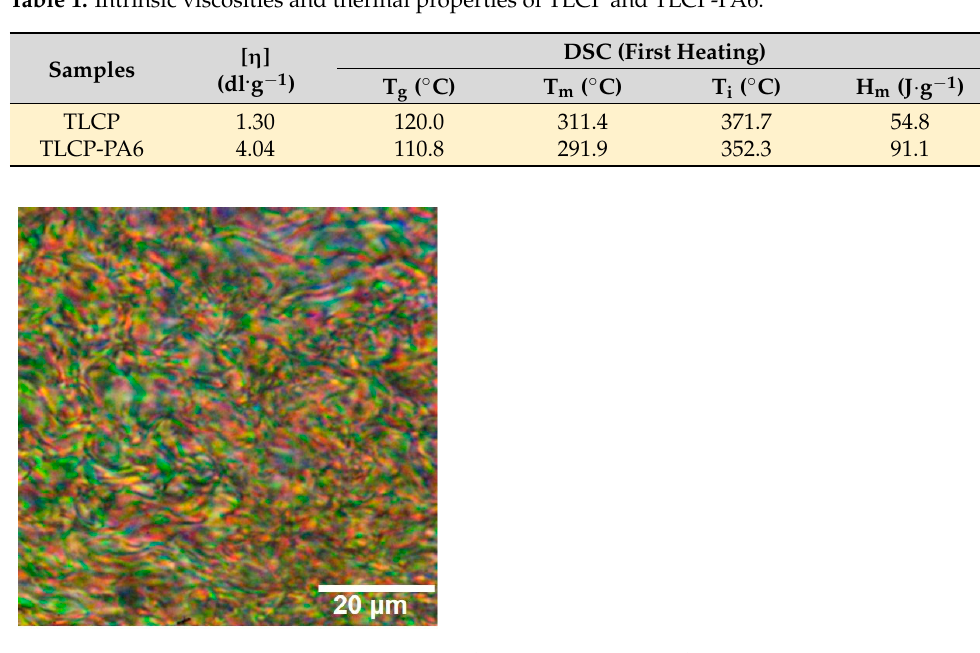
Figure 3. The POM image of TLCP-PA6 at 300 °C (cooling from 340 °C, cross